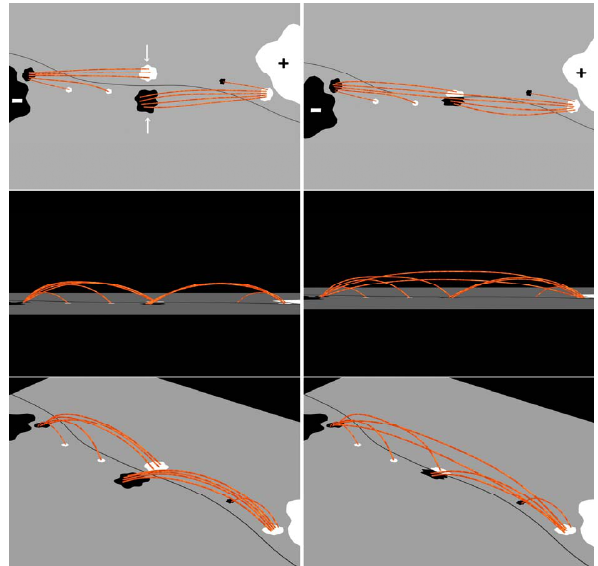
Fig. 2. A thread model schematic of how we interpret the observed Figure 2. A thread model schematic of how we interpret the observed canceling magnetic canceling magnetic fields. White represents positive polarity and fields. White represents positive polarity and black is negative polarity. Cancellation is black is negative polarity. Cancellation is interpreted as magnetic interpreted as magnetic reconnection near the photosphere in which the line of sight magnetic reconnection near the photosphere in which the line-of-sight mag- field in the photosphere is transferred to horizontal magnetic field in the corona. The filament netic field in the photosphere is transferred to horizontal magnetic spine forms along the resulting horizontal component of the field in the low corona and field in the corona. The filament spine forms along the resulting between the more vertical opposite polarity magnetic fields. horizontal component of the field in the low corona and between the more vertical opposite polarity magnetic fields.